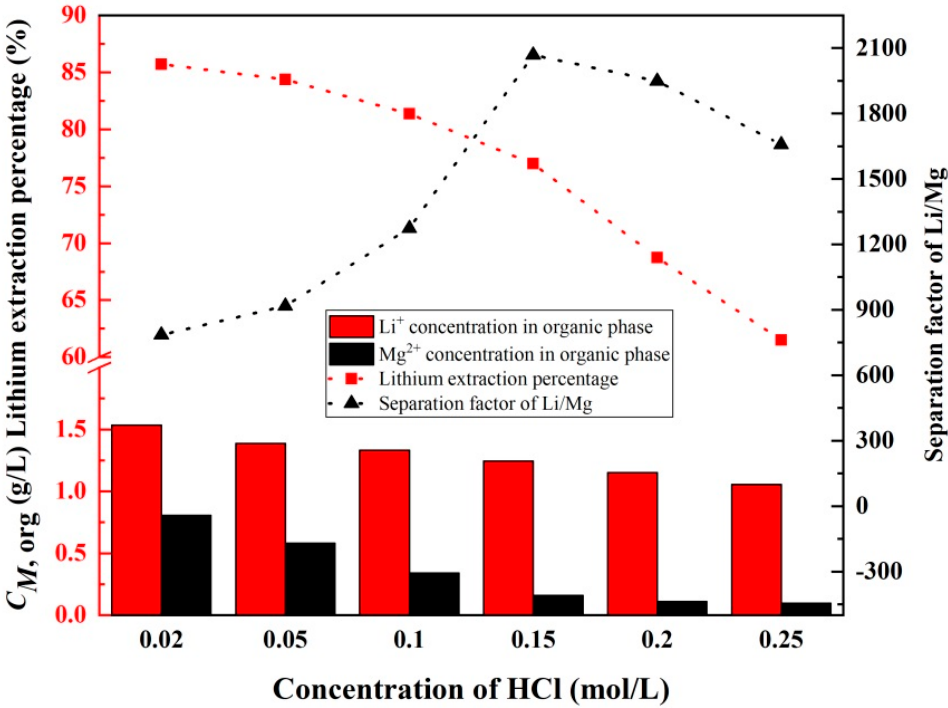
Figure 1. Effect of HCl concentration in aqueous